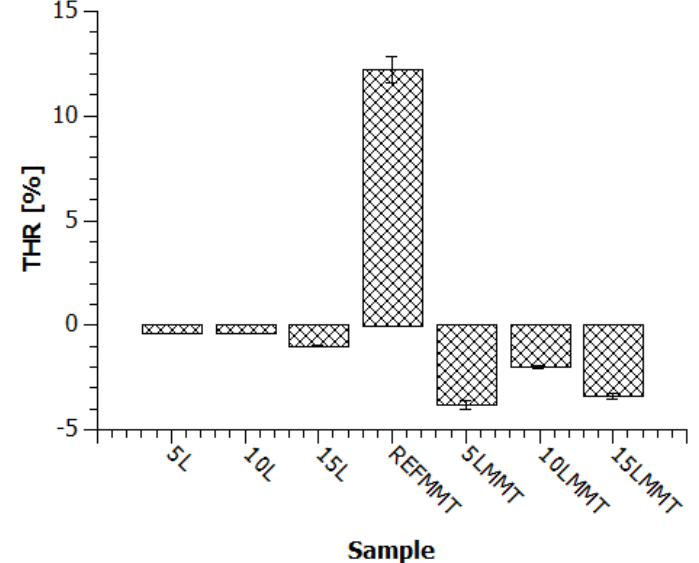
Figure 6. The total amount of heat released (THR) emitted by PA6 coated using the LbL method, compared with the REF material.